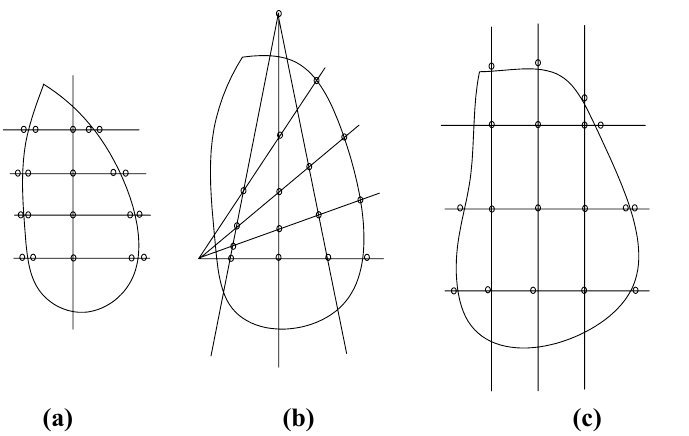
Figure 20. Normal surface displacement monitoring network.